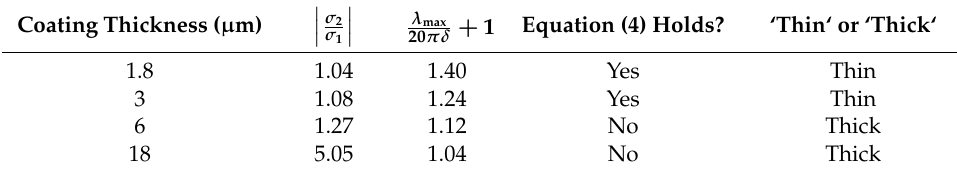
Table 1. Categorization of coatings with different thicknesses into ‘thin’ and ‘thick’.